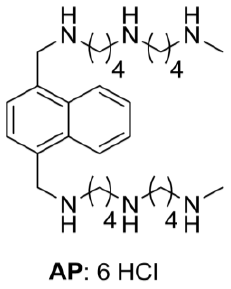
Figure 1. Structure of the arylpolyamine (AP).